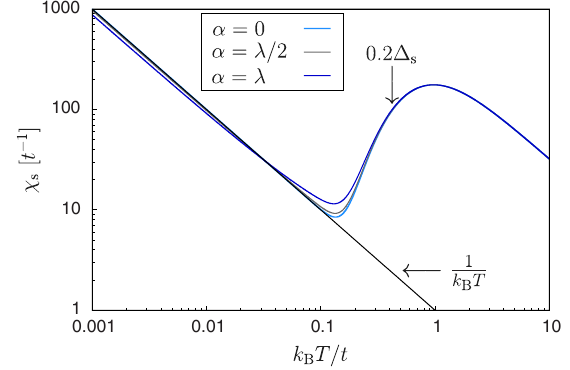
FIG. 3. Spin susceptibility of the Kane-Mele model ( (cid:4)=t ¼ 0 : 2 ) with two (cid:1) fluxes at the maximal distance on an 18 (cid:4) 18 lattice, for different Rashba couplings (cid:5) . At tempera- T & 0 : 1 t , each (cid:1) flux contributes 1 to the suscepti- tures k 2 k B B T (cid:6) 1 . Also shown is the spin-gap energy bility, leading to (cid:9) s k B T for T ¼ 0 , (cid:5) ¼ 0 . For (cid:5) > 0 , the chemical potential scale 0 : 2(cid:1) s is adjusted to retain a half-filled band.